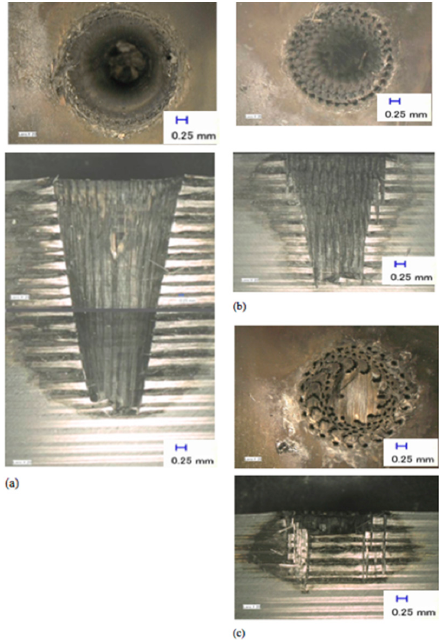
Figure 16. Influence of modulated laser beam on hole depth and HAZ at pulse ratio: ( a ) 10:10 ms, ( b ) 10:50 ms and ( c ) 10:90 ms.